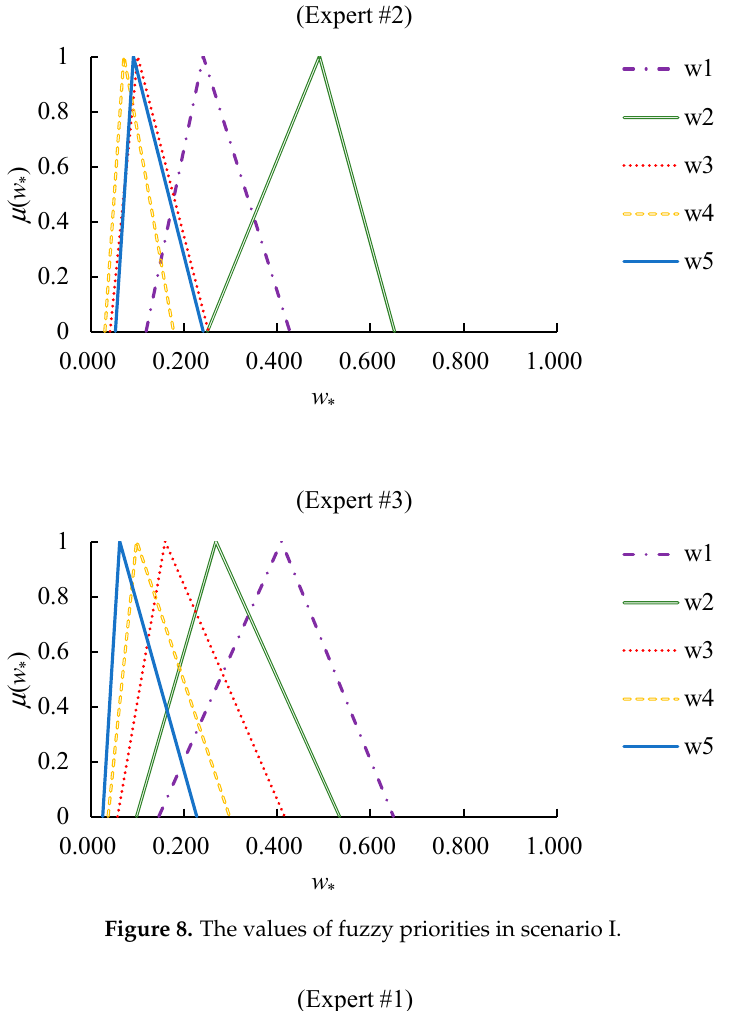
Figure 8. The values of fuzzy priorities in scenario I.